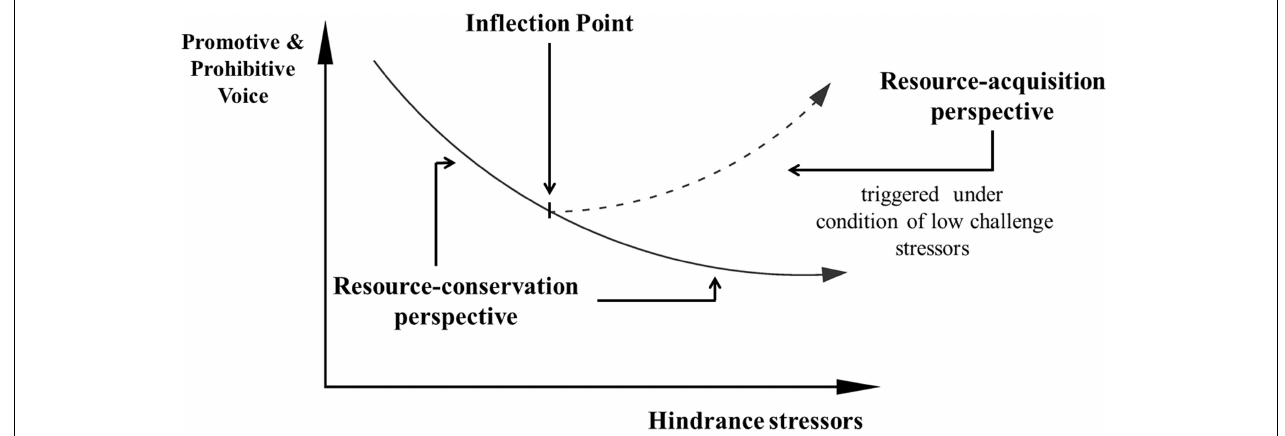
FIGURE 1 | The relationship between hindrance stressors and voice: the resource-conservation perspective versus the resource-acquisition perspective triggered by different conditions of challenge